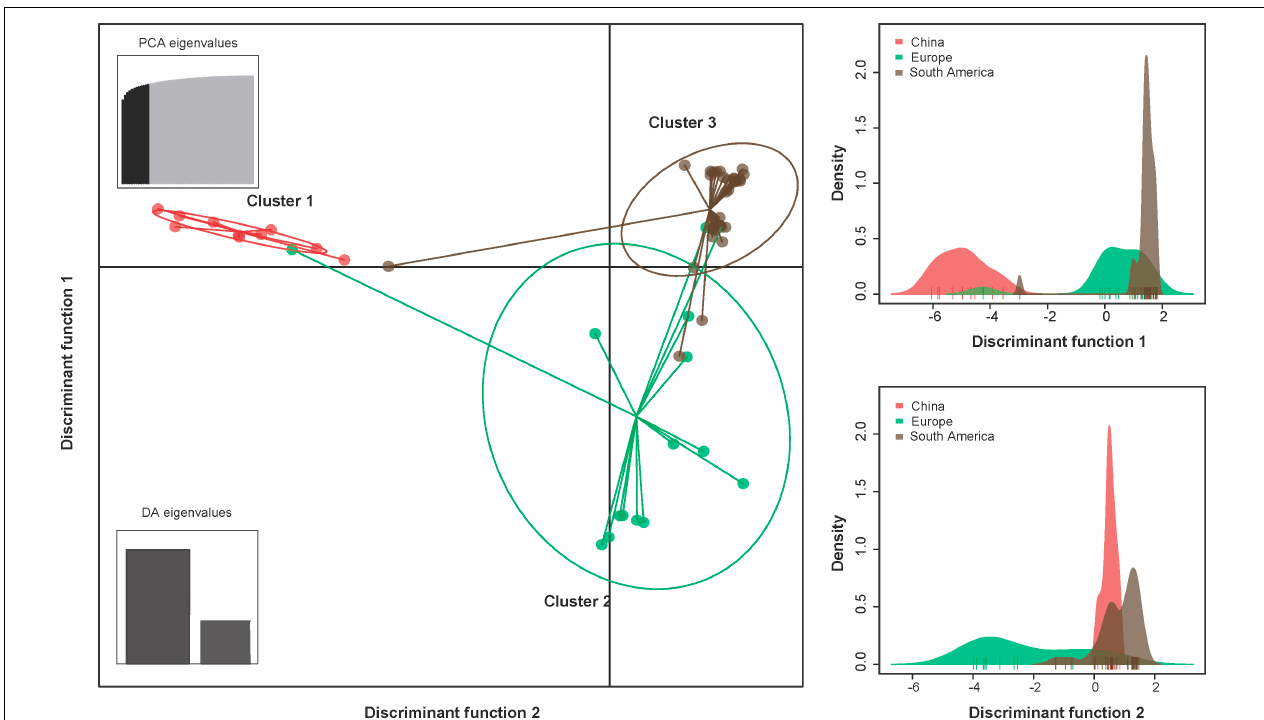
FIGURE 2 | The discriminant analysis of principal components (DAPC) for the geographic structure of PVA isolates from potato. The graph represents the individuals as dots and the groups as inertia ellipses. The bar plots of eigenvalues for the analysis are shown in the inset panel. The density of individuals according to clusters identified along the discriminant function is shown in the right panel. Diagram showing the genomic structure of the PVA genome is shown in the top panel. Viral isolates infecting potato from North America and Oceania were excluded from the analysis due to inadequate sample size ( n ≤